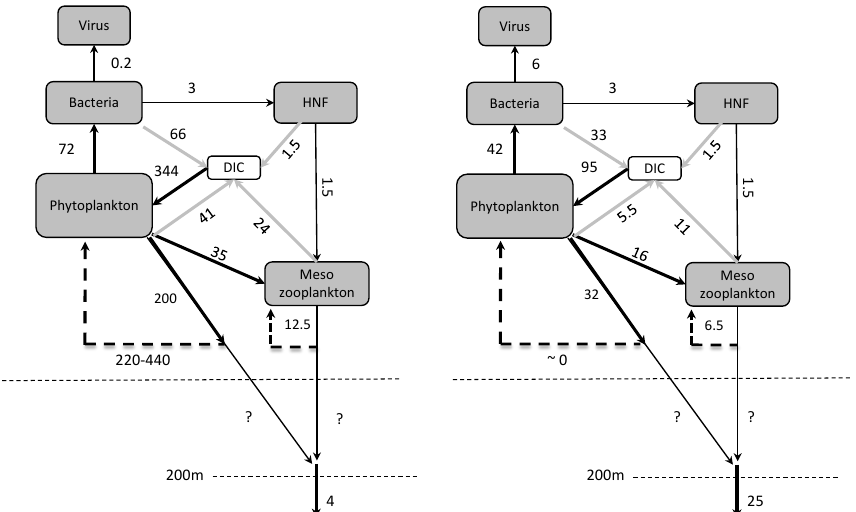
Figure 6. Schematic presentation of the carbon flow through the microbial and higher trophic level food webs during the early (KEOPS2) and late stage of the bloom (KEOPS1) at the southeast bloom above the Kerguelen plateau (station A3). KEOPS1 values are the mean obtained from four consecutive visits at station A3, except for dark community respiration for which only the first three visits were considered. Black arrows indicate the transfer of carbon between microbial and/or higher trophic level food web components, and export. Dashed black arrows going back to “phytoplankton” and “mesozooplankton” indicate possible accumulation of their biomass per day once the respiration and export were subtracted (for details cf. Sect. 4.3). Arrows in grey indicate rates of respiration. Numbers in italics are based on the following estimations: (i) the transfer from HNF to mesozooplankton is calculated from bacterial grazing assuming a 50% transfer efficiency. (ii) the mesozooplankton ingestion and respiration rates were calculated from the respective rates during the late bloom phase and extrapolated according to the depth of the mixed layer ( Z ML ) . All fluxes are integrated over the ML and units are mmol Cm − 2 d − 1 . Late bloom data from Carlotti et al. (2008), Christaki et al. (2008), Lefèvre et al. (2008), Obernosterer et al. (2008), Savoye et al. (2008) and Malits et al. (2014). Early bloom data from Planchon et al. (2014) and Carlotti et al. (2014) for GCP the O 2 -measured fluxes have been converted into C-fluxes using PQ = 1.8 KEOPS2 unpublished data. DIC: dissolved inorganic carbon, Z ML : depth of the mixed